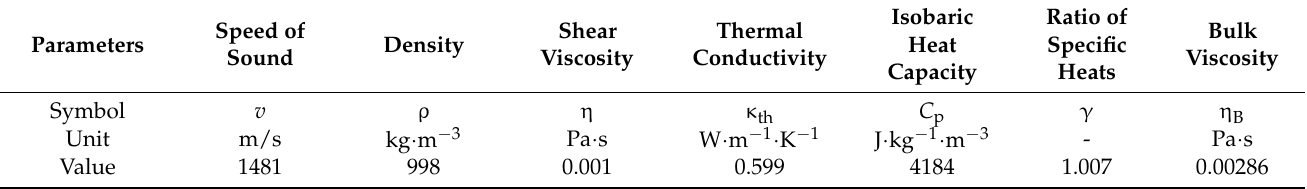
Table 1. Parameters of water at a temperature of 20 ◦ C used in this study.